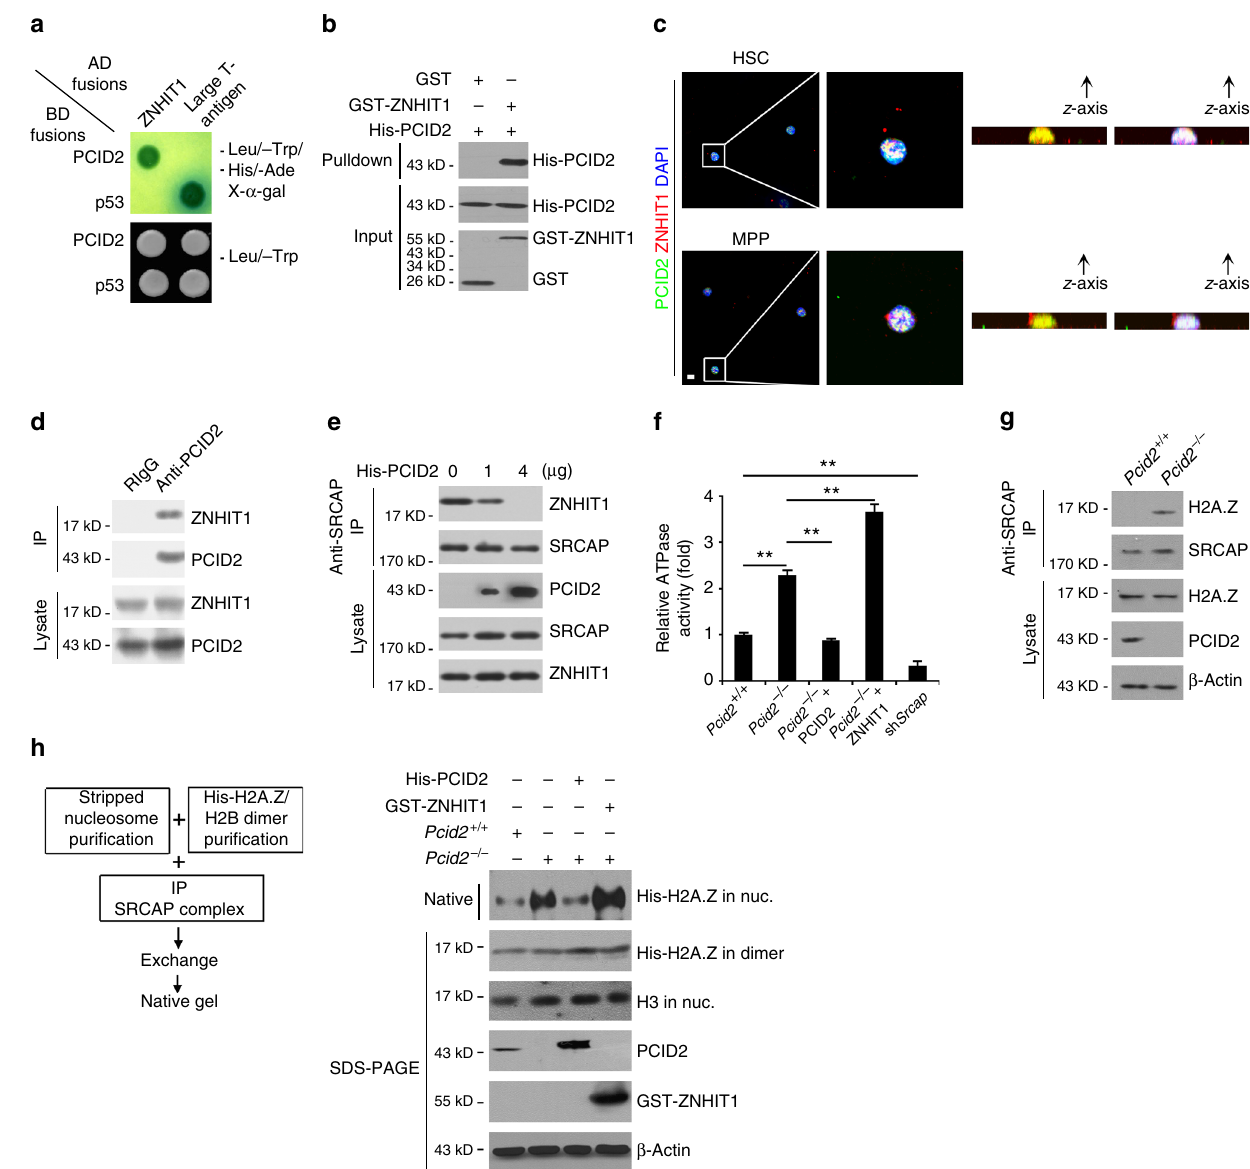
Fig. 4 PCID2 interacts with ZNHIT1 to block SRCAP complex activity causing prevention of H2A/H2A.Z exchange. a PCID2 associates with ZNHIT1 by yeast two-hybrid screen. Yeast strain AH109 was co-transfected with Gal4 DNA-binding domain (BD) fused PCID2 and Gal4 activating domain (AD) fused ZNHIT1. Interaction of BD-p53 and AD-large T antigen was used as a positive control. b GST-ZNHIT1 was incubated with His-PCID2 protein followed by pulldown assays. c Mouse BM HSCs and MPPs were sorted, fi xed and co-stained with the indicated antibodies. PCID2, green; ZNHIT1, red; nucleus, blue. Scale bar, 10 μ m. Z -stack projection was performed to show nuclear co-localization. More than 50 cells of each group were analysed in three individual experiments. d LSK lysates were incubated with anti-PCID2 antibody. PCID2-associated ZNHIT1 was detected by immunoblotting. IP immunoprecipitation, RIgG rabbit IgG. e Recombinant PCID2 protein inhibited the binding of ZNHIT1 with SRCAP. MPP lysates were incubated with anti-SRCAP antibody and protein A/G beads in 4 °C overnight. Recombinant PCID2 protein was added with different concentrations, followed by anti-SRCAP antibody precipitation. f Srcap silenced MPPs (sh Srcap ) were sorted from recipient mice transplanted with shRNA-retrovirus infected HSCs. MPP lysates were immunoprecipitated by anti-SRCAP antibody, followed by detection of ATPase activities. Mouse IgG IP was used as a background control. Puri fi ed His- tagged PCID2 or GST-tagged ZNHIT1 protein (4 μ g for each protein) was added into the ATPase reaction buffer. Relative O.D. values were normalized with background controls. Fold changes were shown as means ± S.D. ** P < 0.01. ( n = 6). Student ’ s t -test was used as statistical analysis. g MPP lysates were immunoprecipitated with anti-SRCAP antibody followed by immunoblotting with the indicated antibodies. h Assessment of histone exchange activity in vitro. Data represent at least three independent experiments PCID2 interacts with ZNHIT1 to block SRCAP complex CD45.1/CD45.2-recipient mice (Fig. 3e and Supplementary activity . To further explore the molecular mechanism that Pcid2 Fig. 4D). Sixteen weeks after transplantation, CD45.2 + T cells and NK cells derived from Pcid2 − / − LT-HSCs were predominant in regulated lineage speci fi cation, we screened a mouse BM cDNA peripheral blood but decreased the numbers of granulocytes library using Pcid2 as bait by a yeast two-hybrid approach. Of the (Fig. 3f). Collectively, Pcid2 functions as a cell intrinsic factor that 57 positive clones we screened out, 13 clones were identi fi ed to be regulates lineage commitment of MPPs. ZNHIT1. ZNHIT1 was further validated to be a interacting NATURE COMMUNICATIONS | 8: 1518 | DOI: 10.1038/s41467-017-01788-7 |